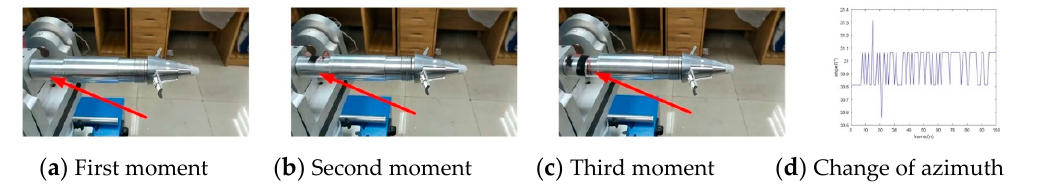
Figure 12. Experiment of mechanical video stabilization.